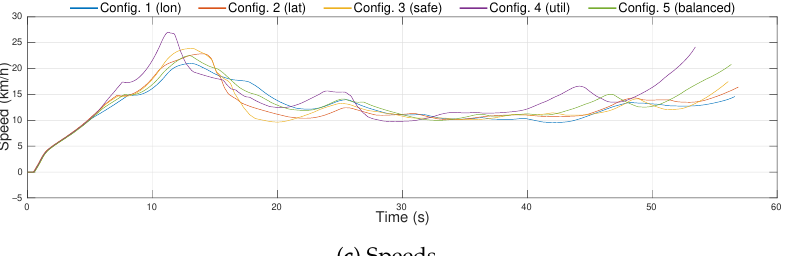
( b ) Lateral accelerations.